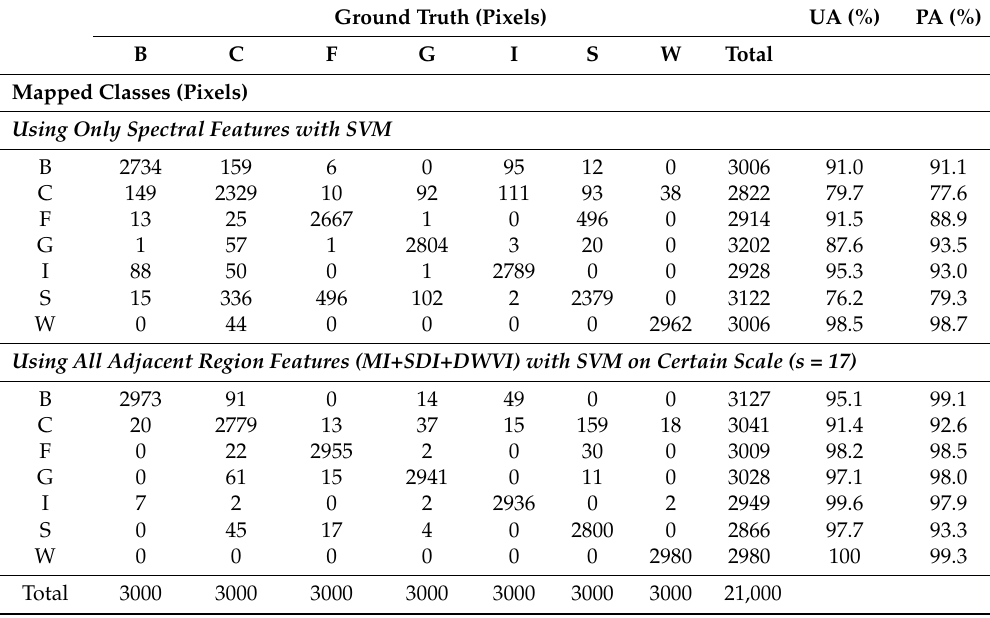
Table 3. Confusion matrixes of LULC Classification using support vector machine (SVM) classifiers with only spectral information and the configuration that achieved the highest overall accuracy